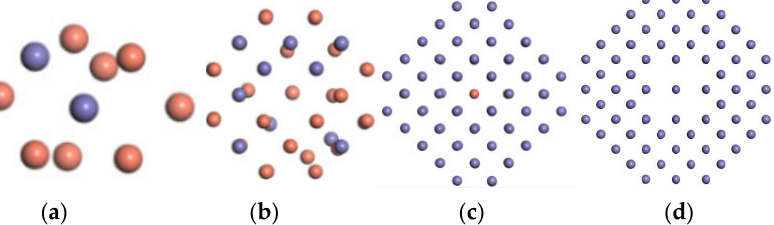
Figure 6. Atomic packing structures in four sub ‐ regions ( a , b , c , d ) along the radial direction from the matrix center at 800 K for Fe bulk –Cu 43 .